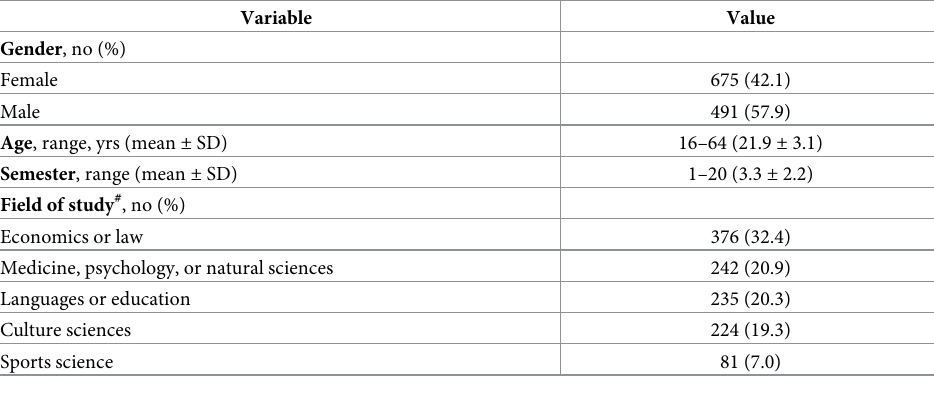
Table 3. Characteristics of the respondents.